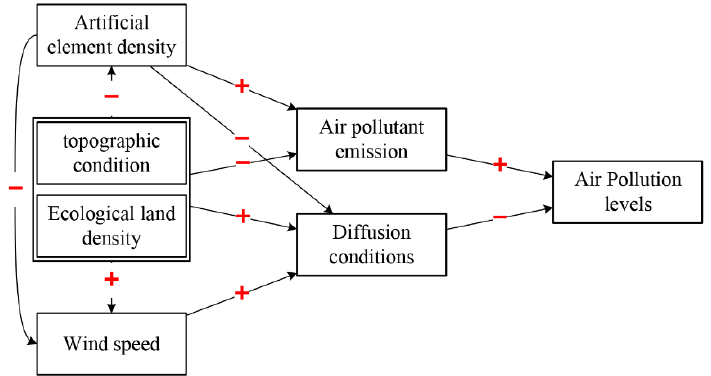
Figure 9. Analysis of the interaction mechanism of factors.